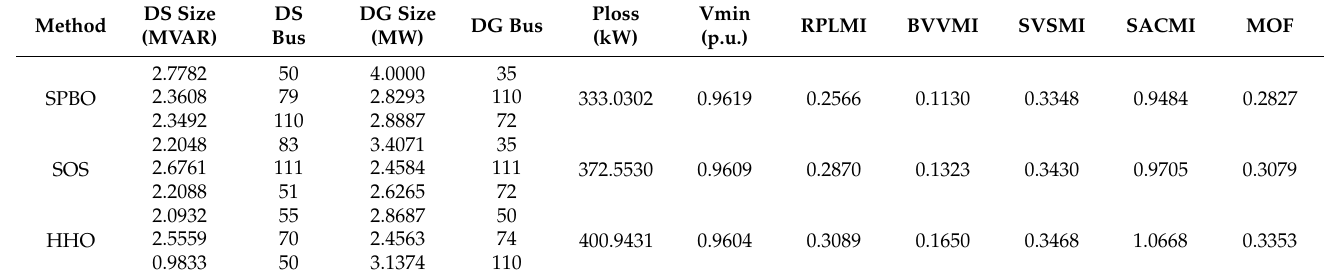
Table 14. Comparison of results for simultaneous DS and 2 PV-DG and 1 GT-DG allocation (case-7) for 118-bus test system.